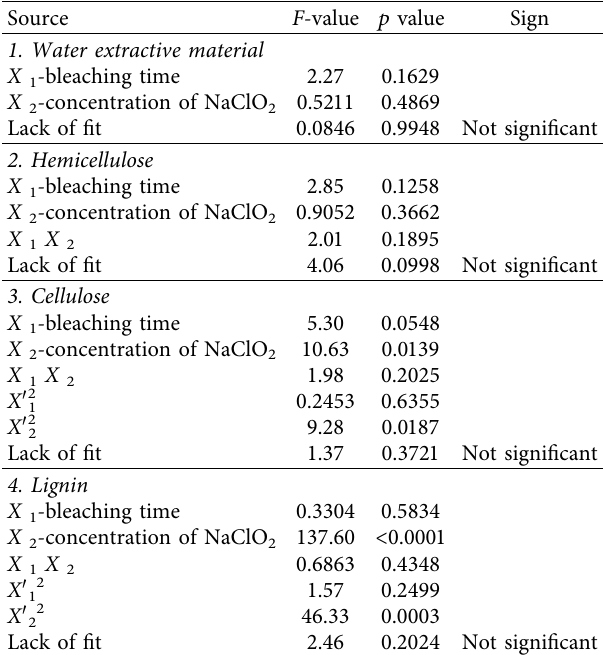
Bold type indicates the suggested model for response. Table 5: Lack of ft